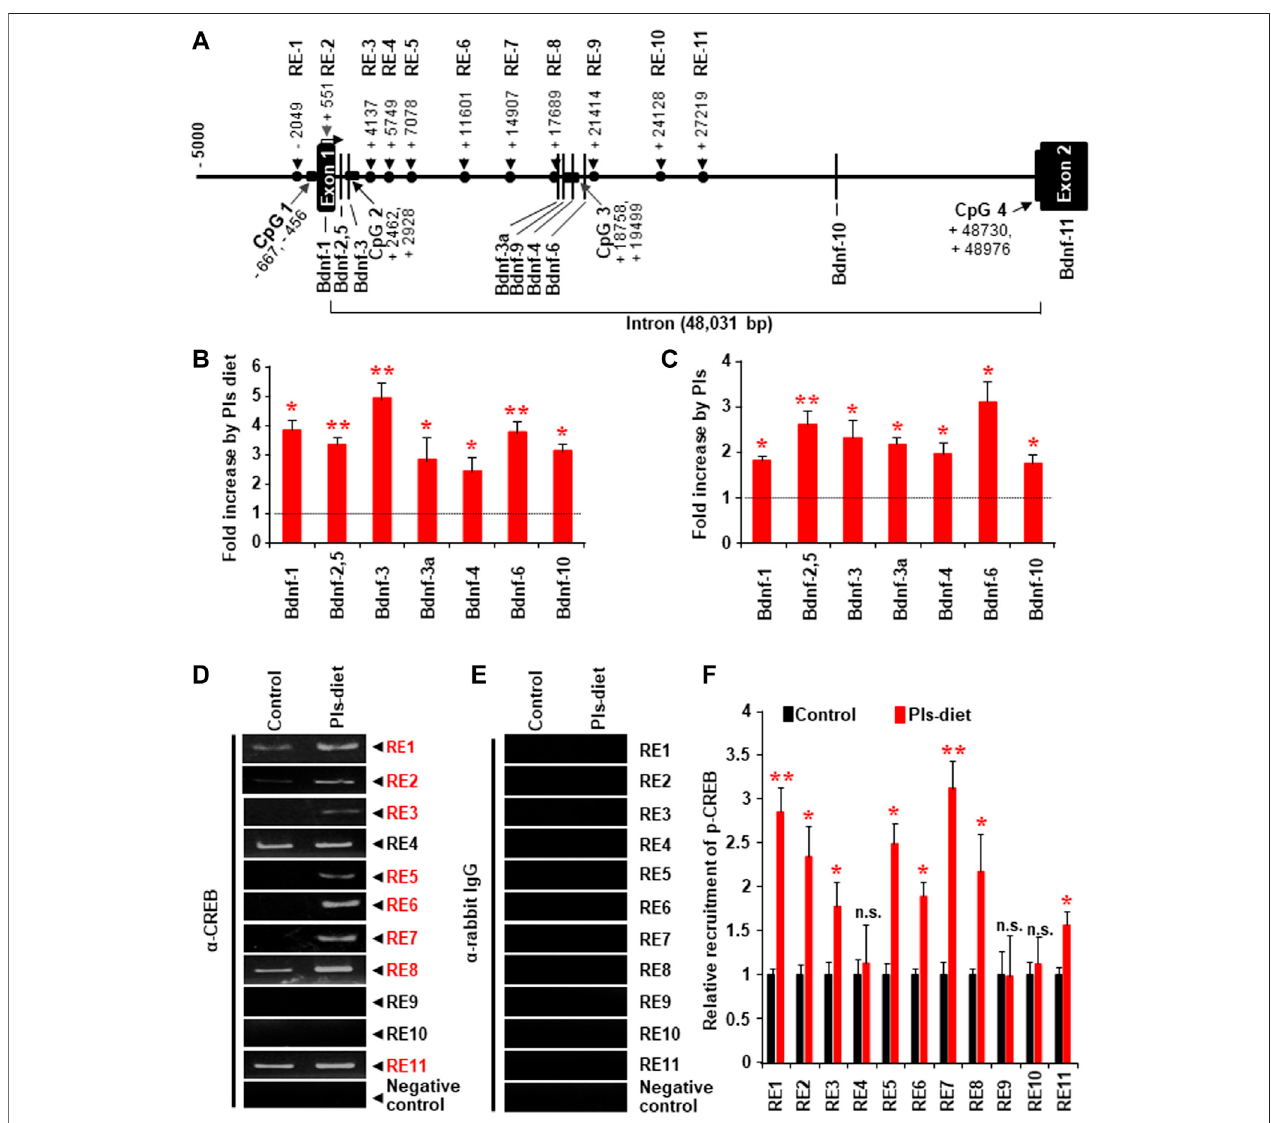
FIGURE 6 | Changes of CREB recruitment onto the Bdnf promoters in the hippocampus tissue by Pls diet. (A) The possible CREB recruitment sites (RE indicates responsiveelement) and thereportedpromotersonto themouse Bdnf genomic DNA. (B) Real-time PCRdatashow therelativeincrease inthe Bdnf transcripts from the differentpromotersbyPlsdietinthemicehippocampus.Thevaluesshowrelativeincreasescomparedwiththecontroldiet( n =5,ineachgroup). (C) Real-timePCRdata show the relative increase in Bdnf transcripts in primary neuronal cells (at DIV 22) cultured with Pls (5 μ g/ml). Pls were added on the DIV3. (D,E) ChIP assays show therelativepulldownofthegenomicDNAfragmentsbythephosphorylatedCREBantibody (D) andthecontrolrabbitIgG (E) inthehippocampusofacontroldietandPls diet mice. (F) Real-time PCR data following the ChIP assays show the relative recruitment of the p-CREB onto the different responsive elements. In panels, (B,C,F) the data represent mean ± S.E.M. ( n = 5, *, p < 0.05 and **, p < 0.01). The p values were calculated by ANOVA followed by Bonferroni ’ s post hoc tests to compare the multiple groups.